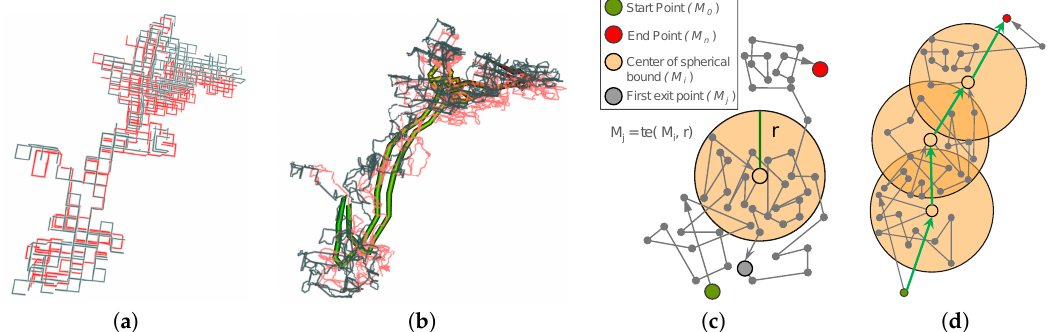
Figure 8. Different simplifications can be applied to a trajectory. The red lines are the acceptor trajectories and the grey-blue lines the donor trajectories. ( a ) One raw trajectory pair, ( b ) charge flow line with abstraction level r = 4 in comparison with Gaussian smoothing n = 4. The charge flow line is colored with respect to time (same color for donor and acceptor). ( c ) The escape time measures the time a charge needs to leave the r -neighborhood of a molecule for the first time. ( d ) charge flow line